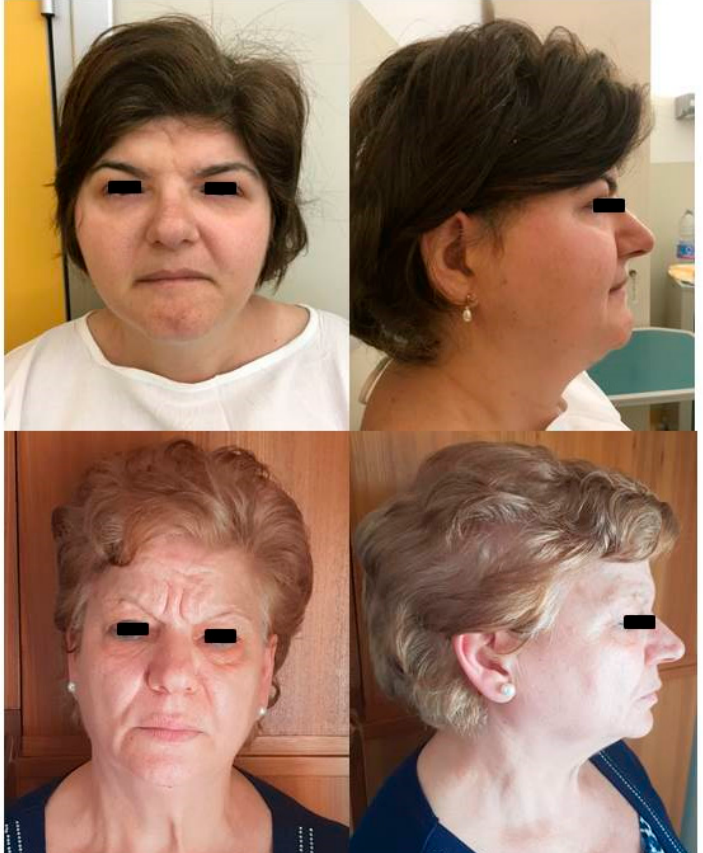
Figure 3. Proband and proband’s mother’s photos. Front and profile photos of the proband (upper panels) and her mother (lower panels). The proband shows peculiar characteristics such as a long narrowing face with bifrontal prominence, low frontal hairline, arched eyebrows, downslanting palpebral fissures, hypertelorism, broad nasal tip, upturned nares, and large and low-set ears. The mother is similar, but not having low frontal hairline and hypertelorism.